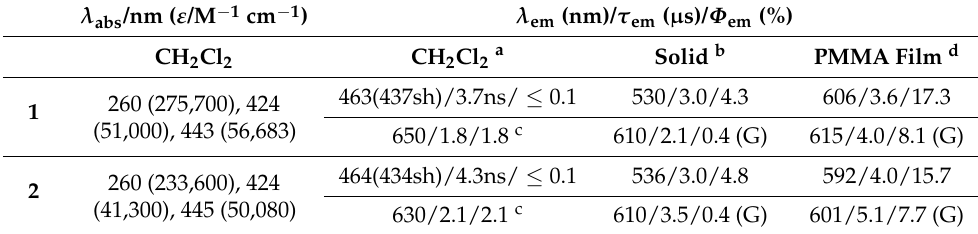
Table 1. The UV-Vis Absorption and Luminescent Data of Complexes 1 and 2 at Ambient